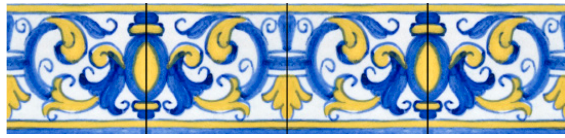
FIGURE 12 | Frame C-17-00140.